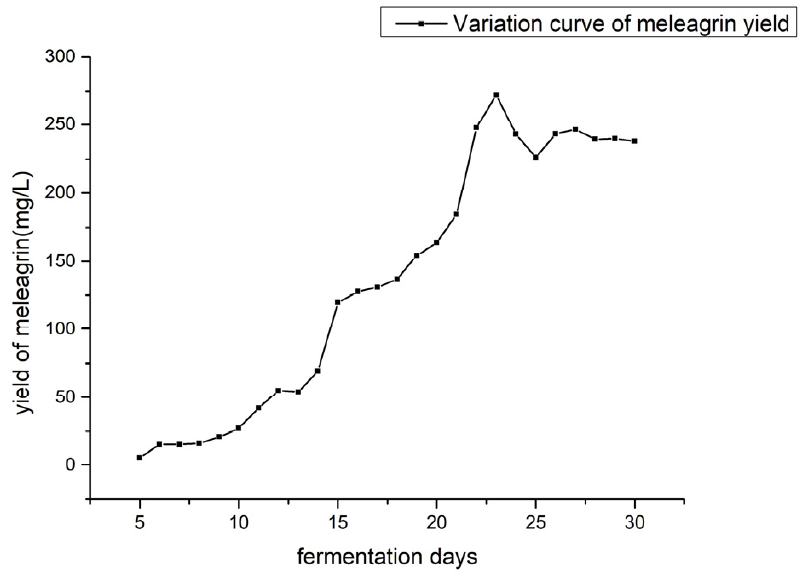
Figure 9. The yield of meleagrain under different fermentation days.